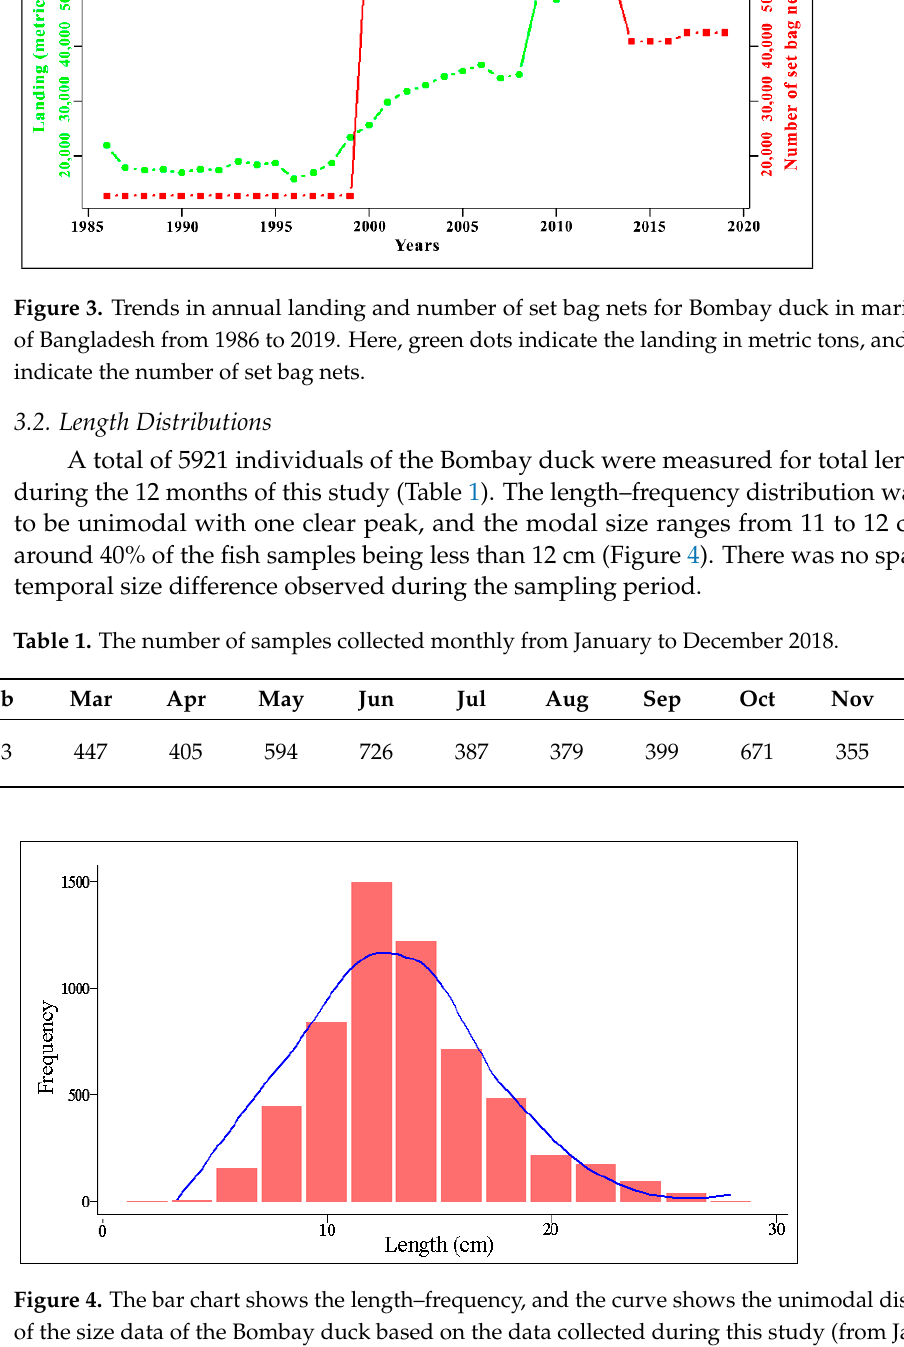
Figure 5. Length-weight relationship of the Bombay duck from the marine water of Bangladesh. 3.4. Growth Parameters and Mortality 3.4.1. Growth Parameters The mean predicted von Bertalanffy growth parameters based on equation (3) were 30.47 cm TL for L ∞ and 0.86 year − 1 for growth coefficient K (Table 2 & Figure 6A), implying that Bombay duck can grow up to a maximum of 30.47 cm TL with a moderately high growth rate if not caught by existing gear. The ELEFAN procedure within the ‘TropFishR’ calculated the mean growth performance index as 2.91 with a high goodness of fit value ( Rn ) of 0.202 (Table 2).